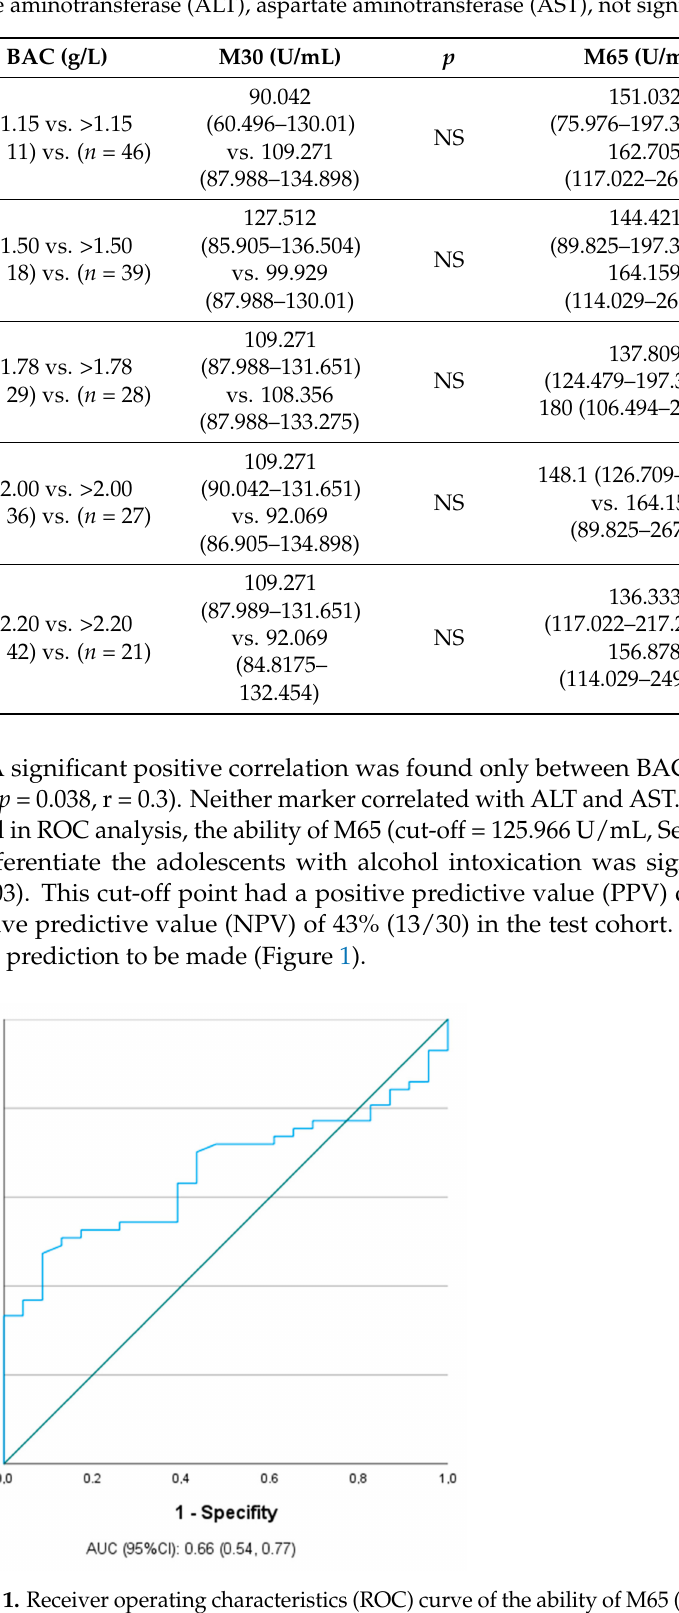
Table 4. Characteristics of the study group in terms of BAC: blood alcohol concentrations (BAC),